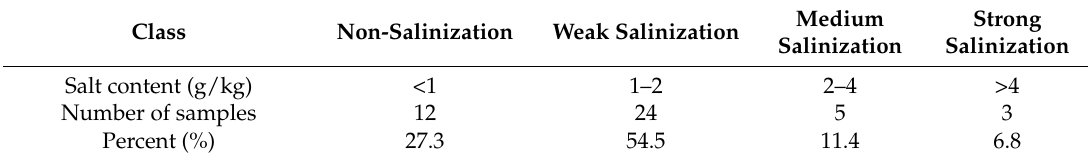
Table 2. Statistical table of salinization soil